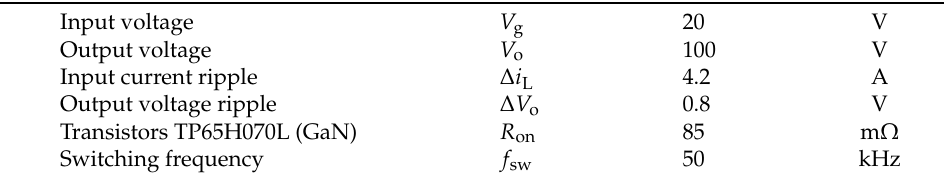
Table 1. Nominal design parameters of all three power converters.